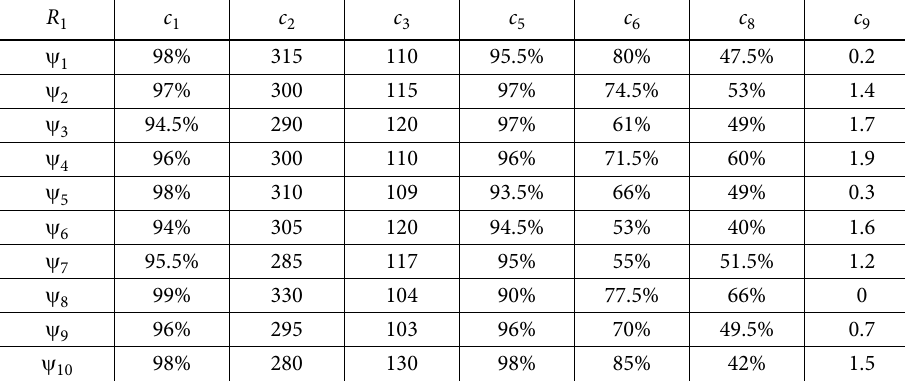
Table 4. The evaluation values provided by ten suppliers.